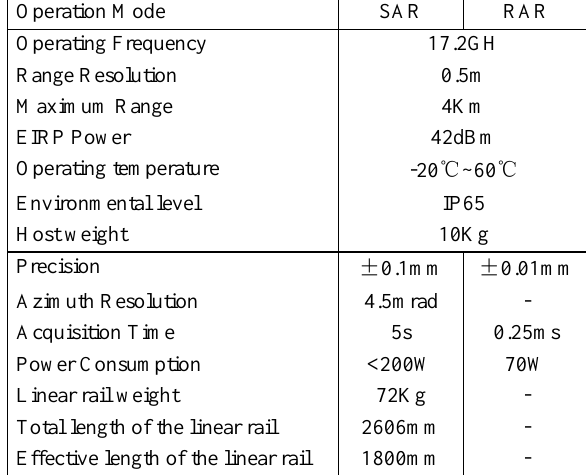
Table 1. Fast-GBSAR specific technical parameters